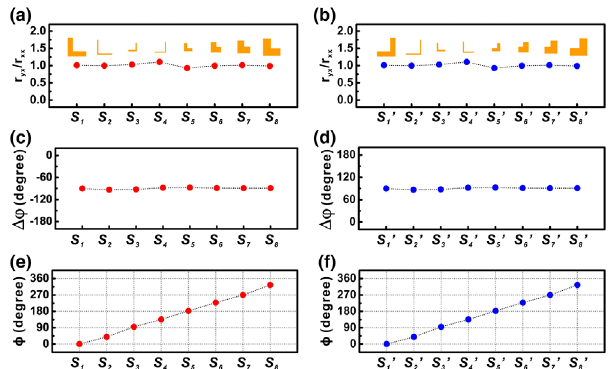
FIG. 2. Simulation results of 16 L -shaped resonators ( S 1 ; S 2 ; … ; S 8 and S 0 1 ; S 0 2 ; … ; S 0 8 ), where the x -polarized incident light propagates in the − z direction, and the wavelength is 1300 nm. (a) The simulated reflectance ratio of the y component and the x component of eight resonators in f S i g ð i ¼ 1 ; 2 ; … ; 8 Þ . (b) The simulated reflectance ratio of the y component to the x component of eight resonators in f S 0 i g ð i ¼ 1 ; 2 ; … ; 8 Þ . (c) The simulated reflected phase difference between the y and x components of eight resonators in f S i g ð i ¼ 1 ; 2 ; … ; 8 Þ . (d) The simulated reflected phase difference between the y and x components of eight resonators in f S 0 i g ð i ¼ 1 ; 2 ; … ; 8 Þ . (e) The simulated GSI phase ϕ added to the diffracted state from the elements in f S i g ð i ¼ 1 ; 2 ; … ; 8 Þ . (f) The simulated GSI phase ϕ added to the diffracted state from the elements in f S 0 i g ð i ¼ 1 ; 2 ; … ; 8 Þ